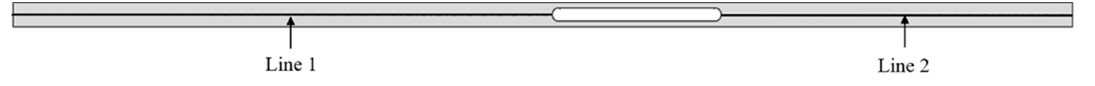
Figure 15. Descriptions of line 1 and line 2 from Figure 12.